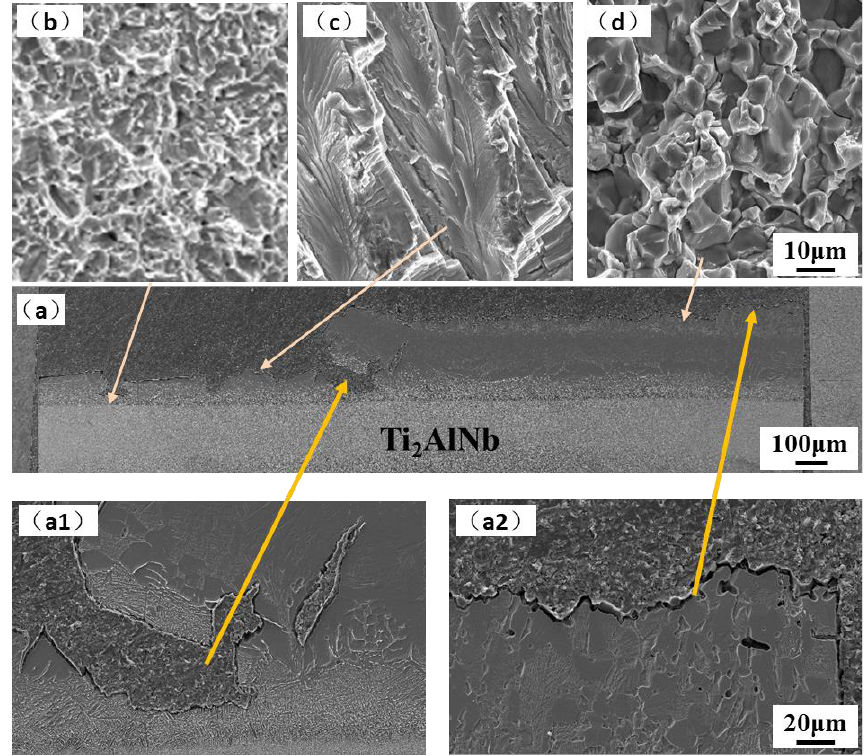
Figure 10. Fracture of 750 ℃ tensile samples: ( a ) cross-section, and ( b – d ) fracture surface. ( a1 ) cross-section near Ti 2 AlNb side ; ( a2 ) cross-section near TiAl side .